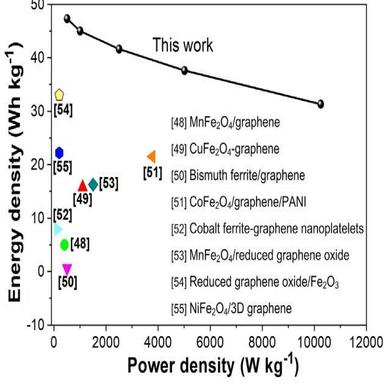
Ragone plots of SrFe12O19 NR/G-29.7 based device and some similar previously reported ferrite/graphene composite based devices.